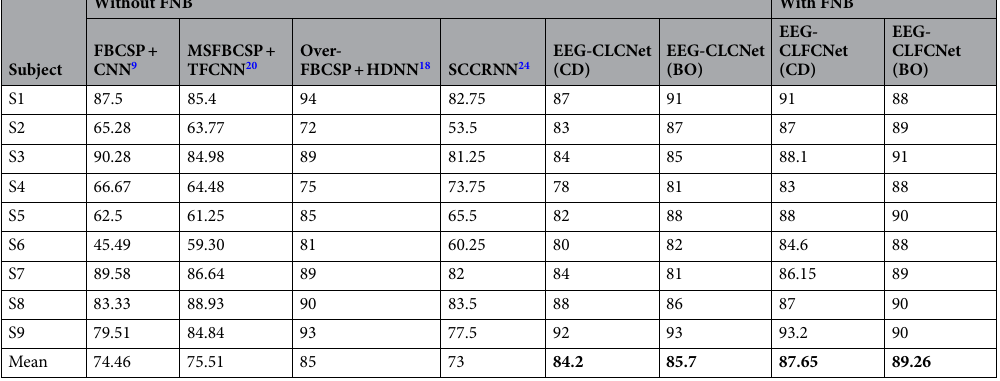
Table 6. Comparison between our networks and previous networks in terms of accuracy values. Significant values are in [bold].